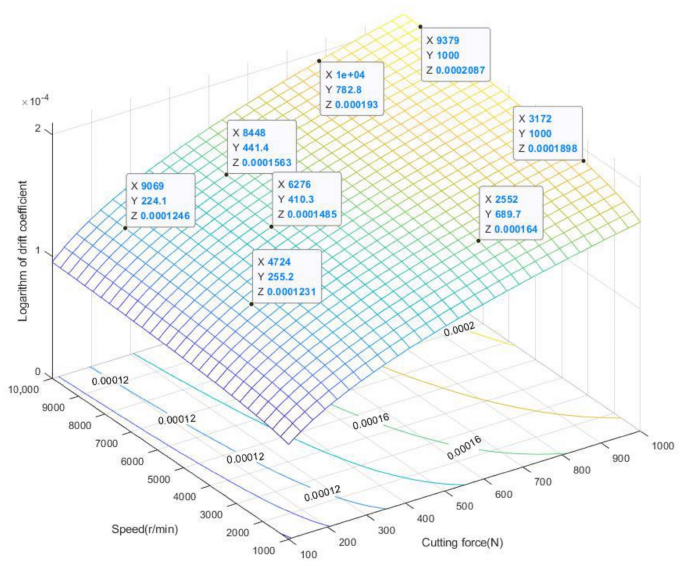
Figure 6. Three-dimensional fitting of the accelerated degradation model of the motorized spindle under two